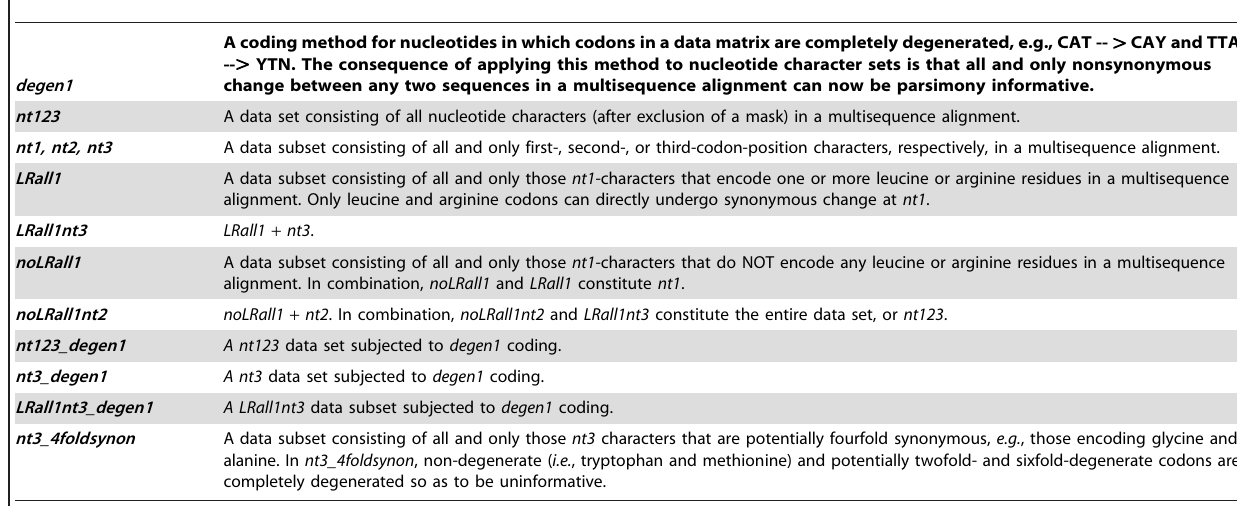
Table 1. Definitions of degen1 coding and of character sets.